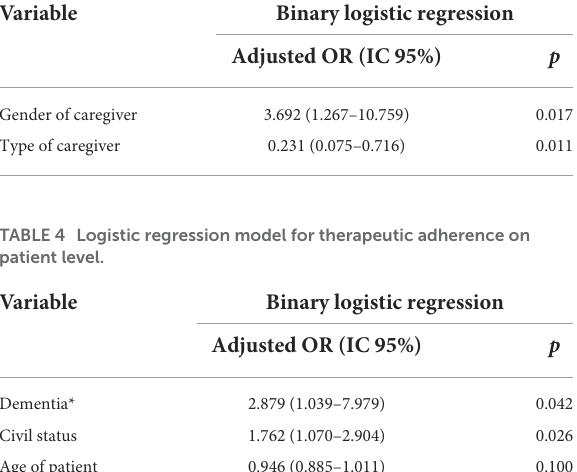
TABLE 3 Logistic regression model for therapeutic adherence on caregiver level.